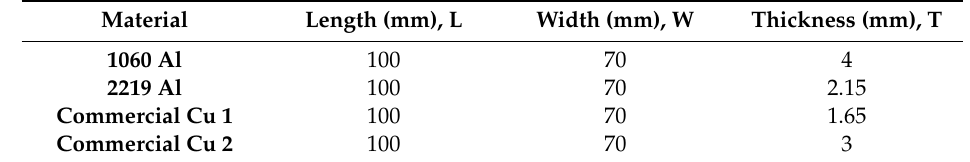
Figure 6. Microscopy and micro-hardness sample. Table 1. Blank size utilized in the present study.